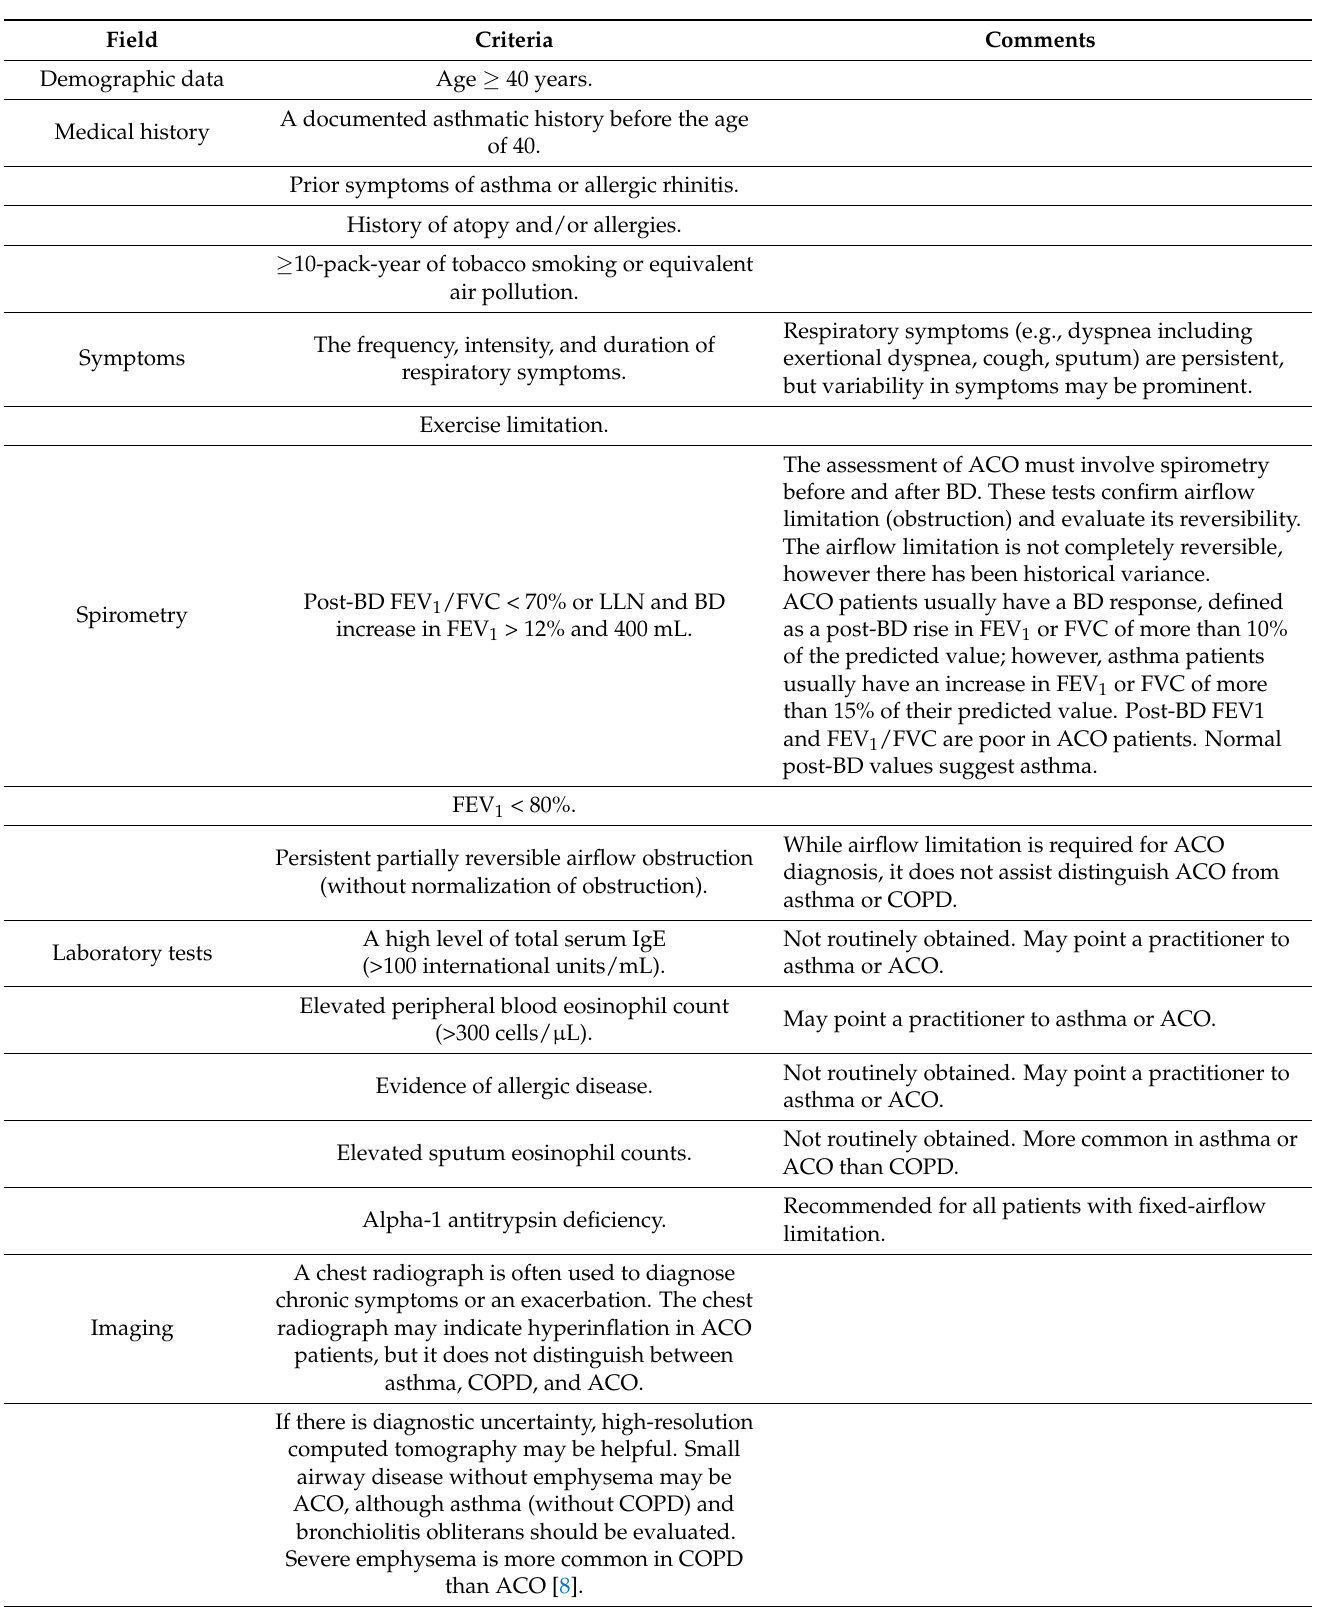
Table 3. The concluded proposed data collection for ACO